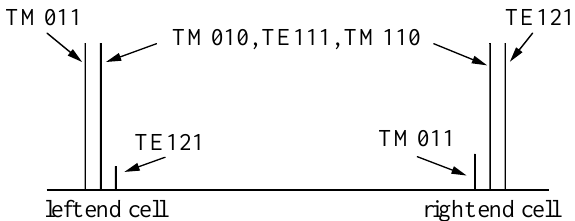
FIG. 10. The effect of asymmetric end cell shaping on vari- ous modes. The main accelerating mode TM 010 and the higher modes TE 111 and TM 110 are not affected while TM 011 is en- hanced in the left end cell and TE 121 is enhanced in the right end cell. Using HOM couplers at both ends, all higher-order modes can be extracted.